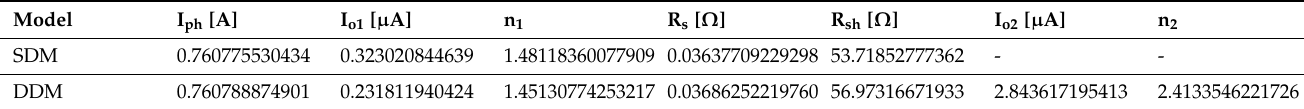
Table 2. The parameters of RTC photovoltaic cell.